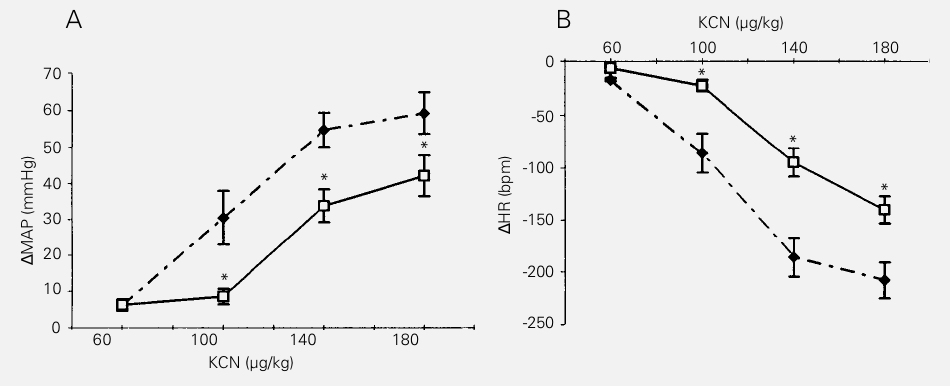
Figure 2 - Line graphs showing the effects of streptozotocin-in- duced diabetes on mean arterial pressure (MAP) responses (A) and heart rate (HR) responses (B) of control ( ¢ , N = 9) and dia- betic ( @ , N = 9) rats to increasing doses of KCN. Data are reported as means – SEM. *P<0.05 com- pared to control